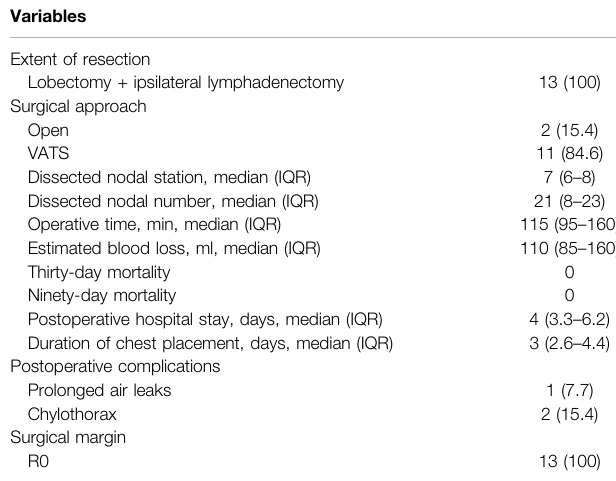
TABLE 2 | Treatment regimens and response assessment. Duration of neoadjuvant therapy, days, median